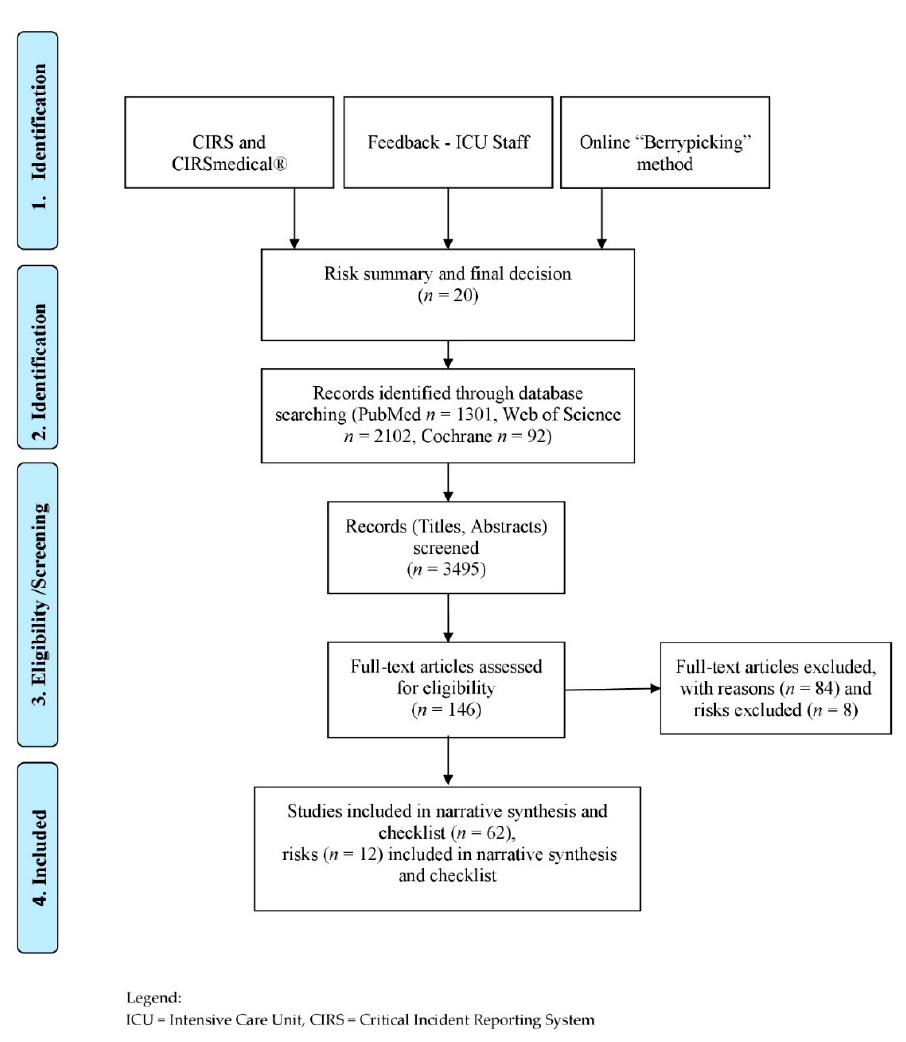
Figure 1. Flow Diagram—Risk identification process and narrative